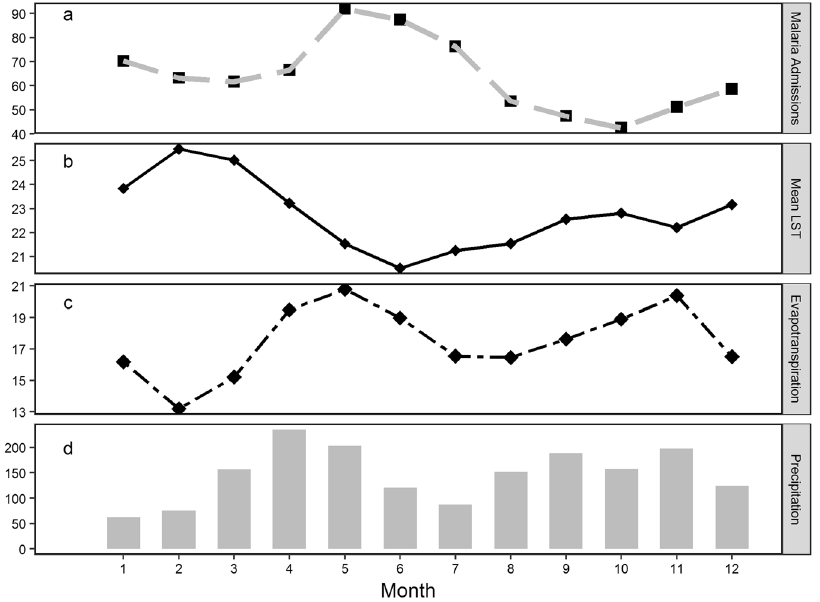
Figure 1. Monthly average of pediatric malaria admissions ( a ), mean LST ( b ), ET ( c ) and precipitation ( d ) in Karemo division, Siaya county, Western Kenya,